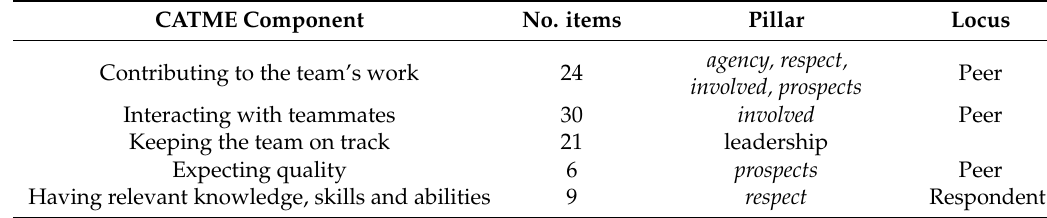
Table 5. Five CATME components and their alignment of constituent questions with Pillars. Also, the locus of perception of the CATME component (but not necessarily of all constituent questions). CATME Component No. items